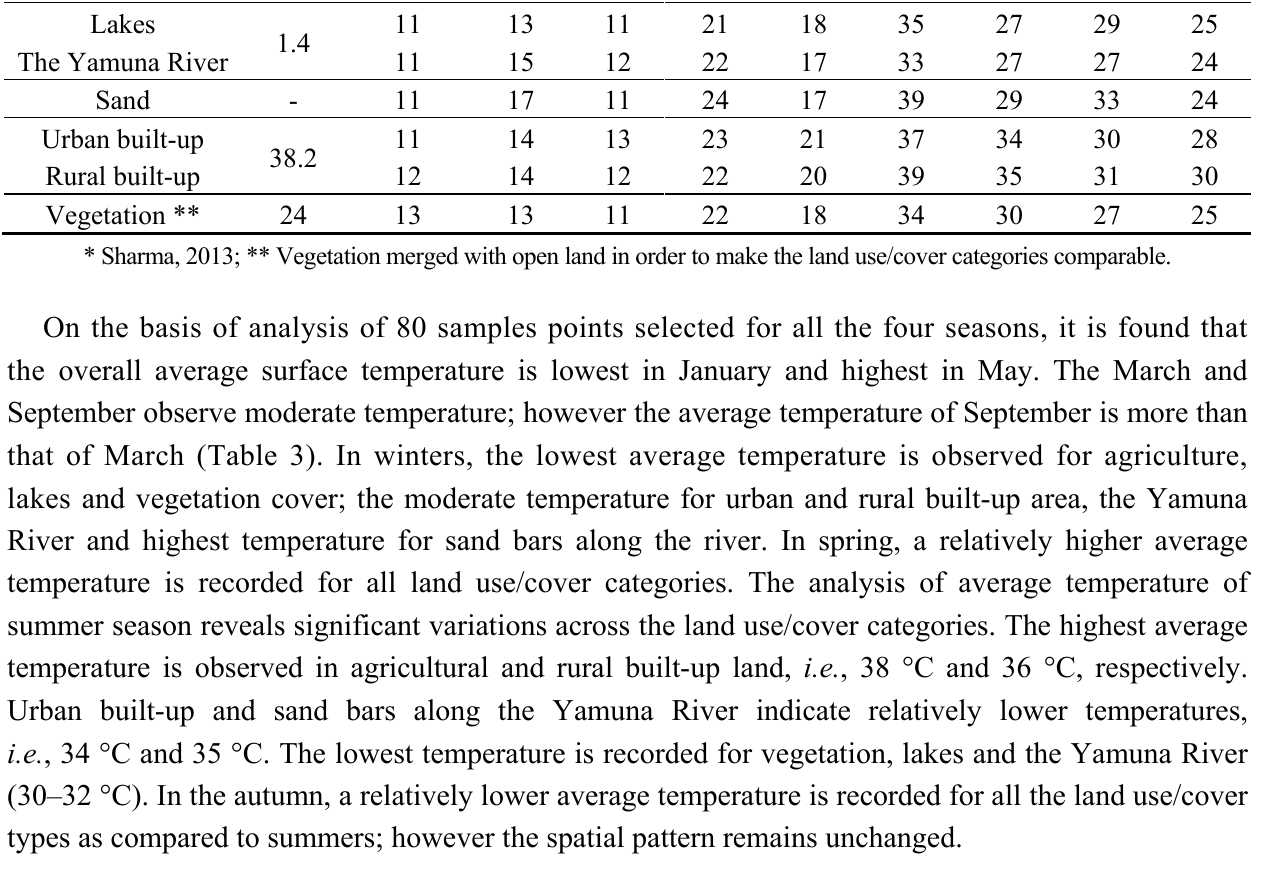
Table 2. Details of land use/cover, number of samples temperature taken from land use/cover and seasonwise maximum and minimum average temperature (°C). Source: Calculated from Landsat TM 5 thermal band.